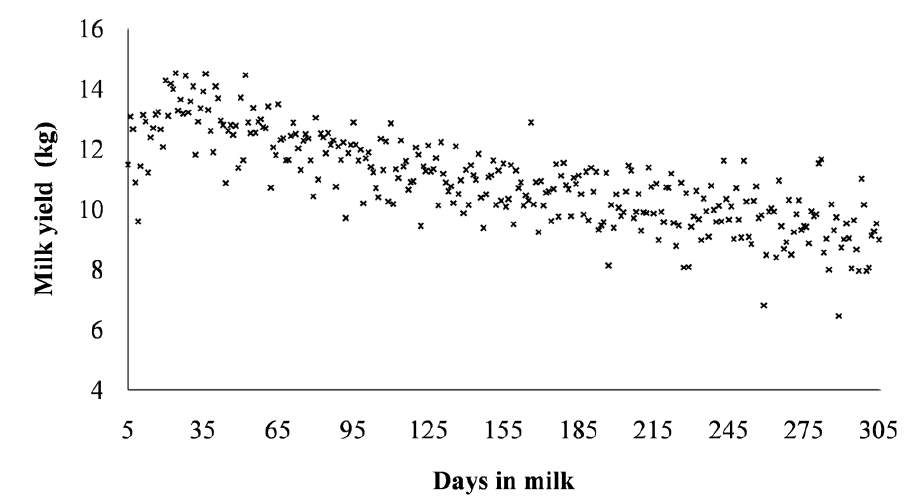
Figure 1. Average test-day milk yield (kg) at different stages in first-lactation Holstein Friesian